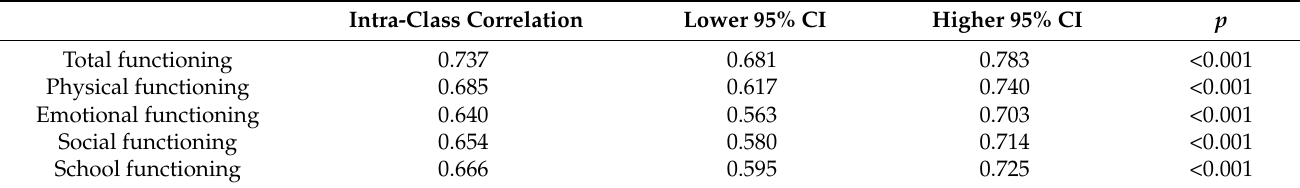
Table 2. Intra-class correlation coefficients (ICC) between adolescent self-report and parent proxy-report.